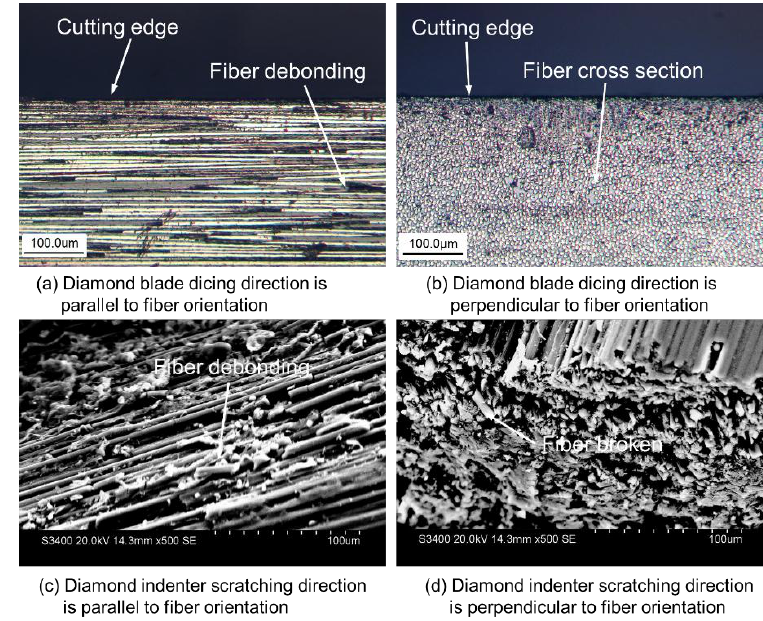
Figure 15. Morphologies of CFRP composites obtained by different cutting methods.